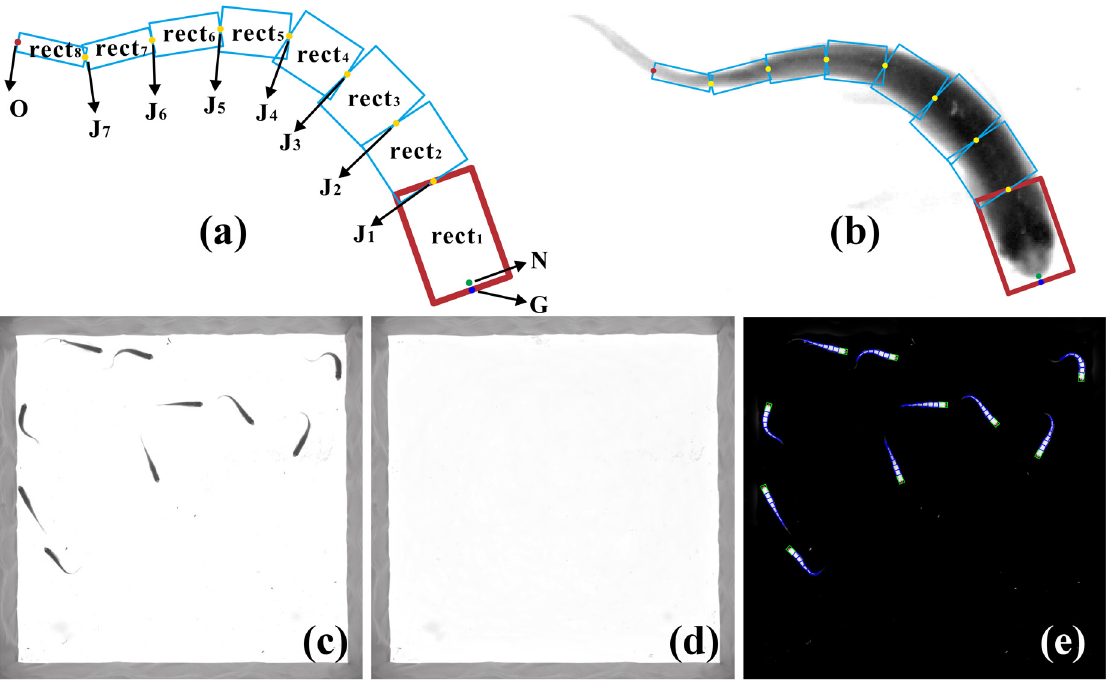
Fig 2. Fish detection. (a). Fish model. The whole fish body is discretized into 8 linked rectangles with adaptable sizes. Green point (point N ) denotes fish nose point. Yellow points mark the joint points. Blue point (point G ) and red point (point O ) is the midpoint on front edge of rec 1 and back edge of rec 8 respectively; (b). Fish model mapped onto real image; (c). One sample image captured with a high speed camera; (d). Background image achieved by calculating average pixel value of a large number of images with fish in the tank; (e). Result of image background subtraction, fish head detection and body fitting by the proposed